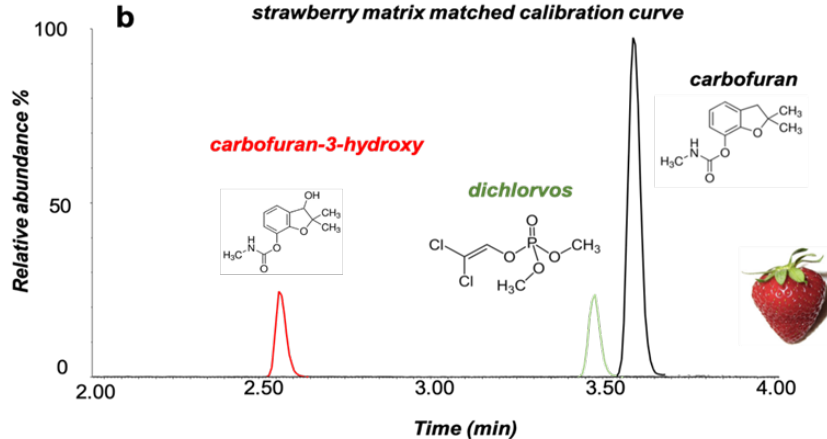
Figure 2. Extracted ion chromatograms (XIC) of carbofuran, carbofuran-3-hydroxy and dichlorvos at 0.020 mg Kg − 1 in ( a ) lettuce and ( b ) strawberry matrix matched solutions using the LC–MS / MS